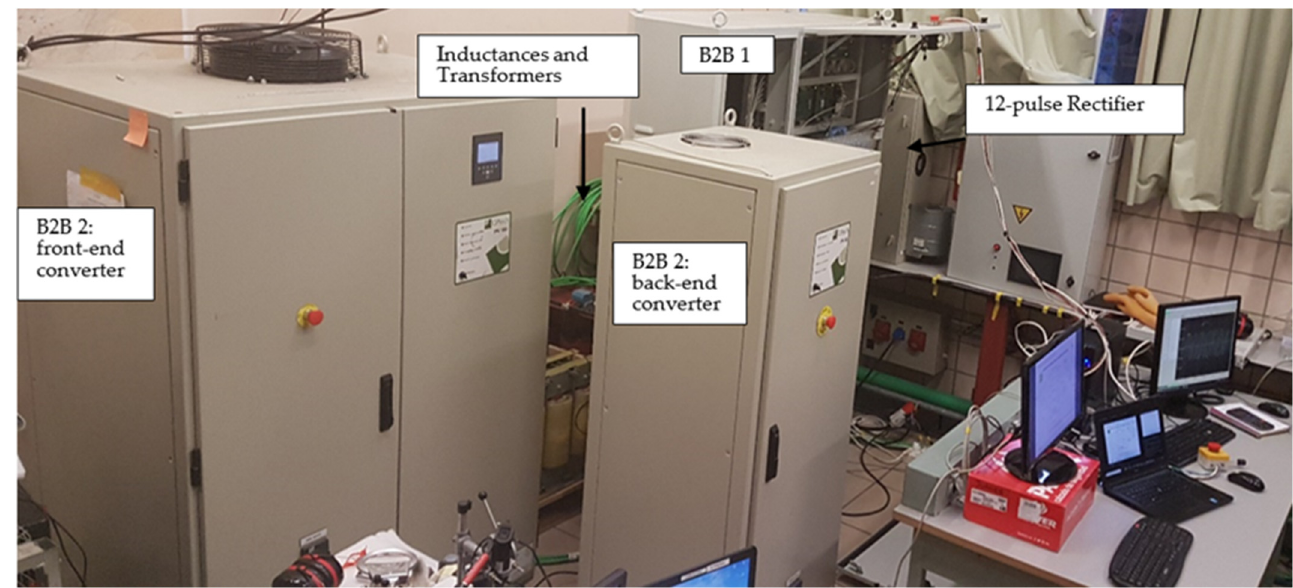
Figure 9. Test bench system components.